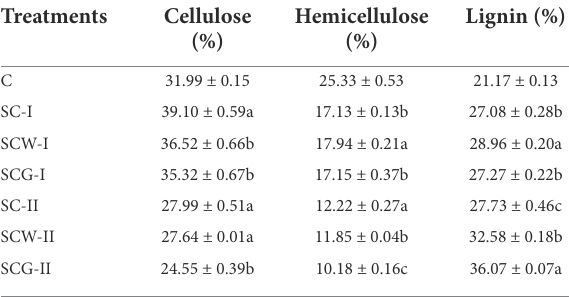
TABLE 4 Cellulose, hemicellulose and lignin content of corn straw samples.